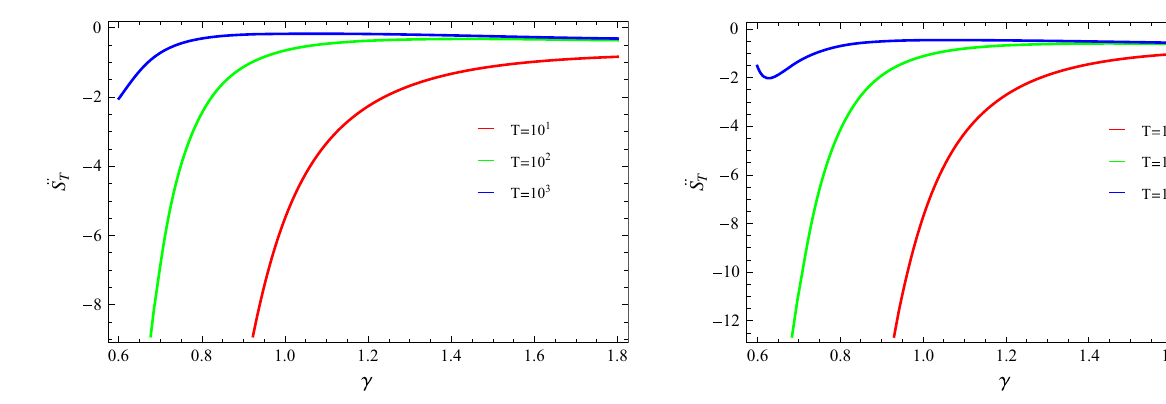
¨ S T against γ is shown in Figure 8 The graphical behavior of − 0 . 53, δ = − 2, L = 1 as shown in Fig. 9. We for three values of T by keeping the constant values as H = , (cid:7) = − 1, q = − 0 . 53, δ = − 2, L = 1. It is found 67, r c = 1 67 ¨ S T < that the trajectories of this plot satisfy the condition 0 for all values of T which leads to the thermodynamical equilibrium of the system.